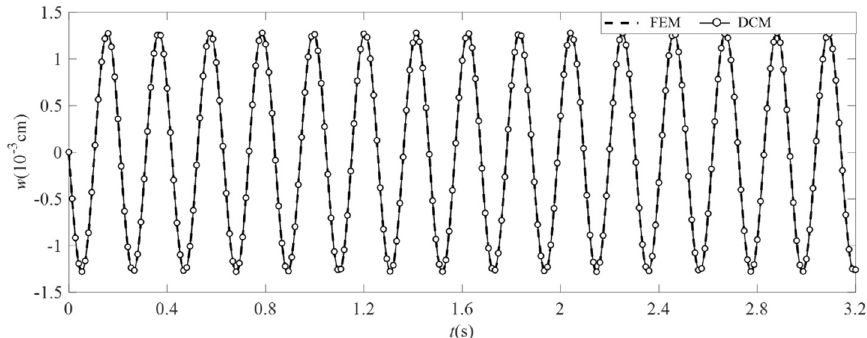
Figure 14. DC solution and finite element solution of time-history displacement of the center point ( T = 3.2 s, FEM ∆ T = 0.05 s).